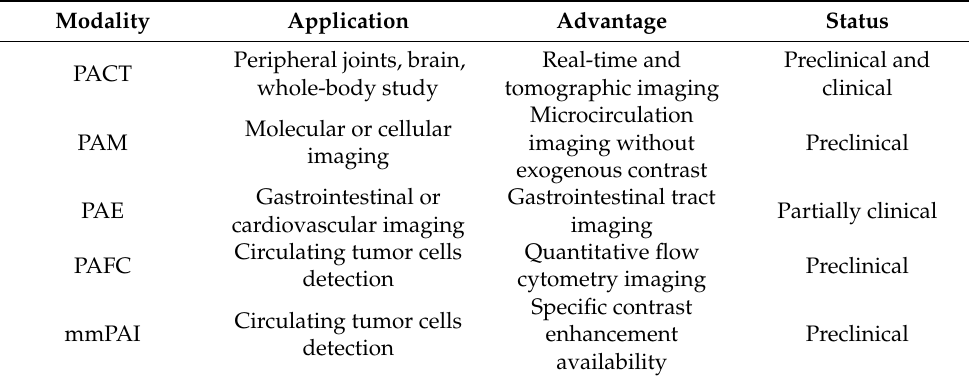
Table 2. Different modalities of PAI. Table reprinted with permission from [70]. Modality Application Advantage Status Peripheral joints, brain, Real-time and Preclinical and PACT whole-body study tomographic imaging Molecular or